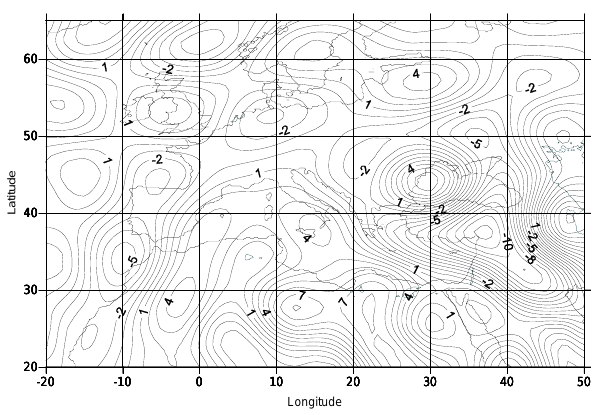
Fig. 9 . The divergence of the horizontal wind